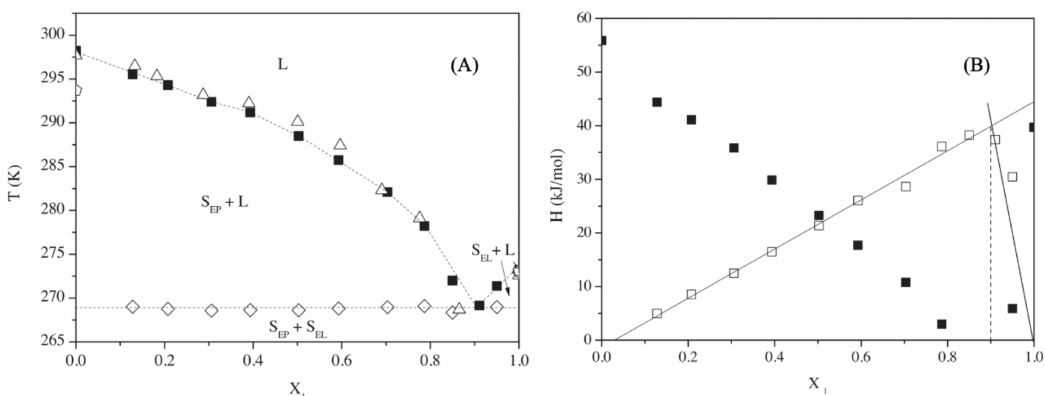
Figure 1. Examples of ( A ) a phase diagram and ( B ) a Tammann plot of the mixture ethyl laurate/ethyl palmitate [45]. In Figure 1A: (cid:4) – liquidus line from [45]; (cid:52) – liquidus line from [42]; – Eutectic temperature; L – Liquid; SEP – Solid Ethyl (cid:51) Palmitate; SEL – Solid Ethyl Laurate. In Figure 1B: (cid:4) – Melting; (cid:3) – Eutectic. Reprinted from Fluid Phase Equilibria, 358, “Solid–liquid equilibrium in ternary mixtures of ethyl laurate, ethyl palmitate and ethyl stearate”, 272–281, Copyright (2013), with permission from